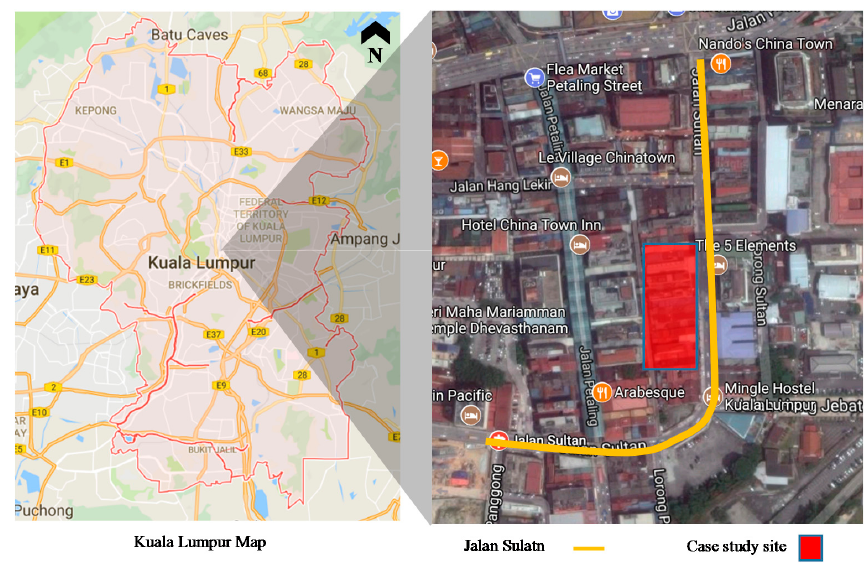
Figure 1. Location of case studies in Kuala Lumpur and Jalan Sultan (Google map, 2017).